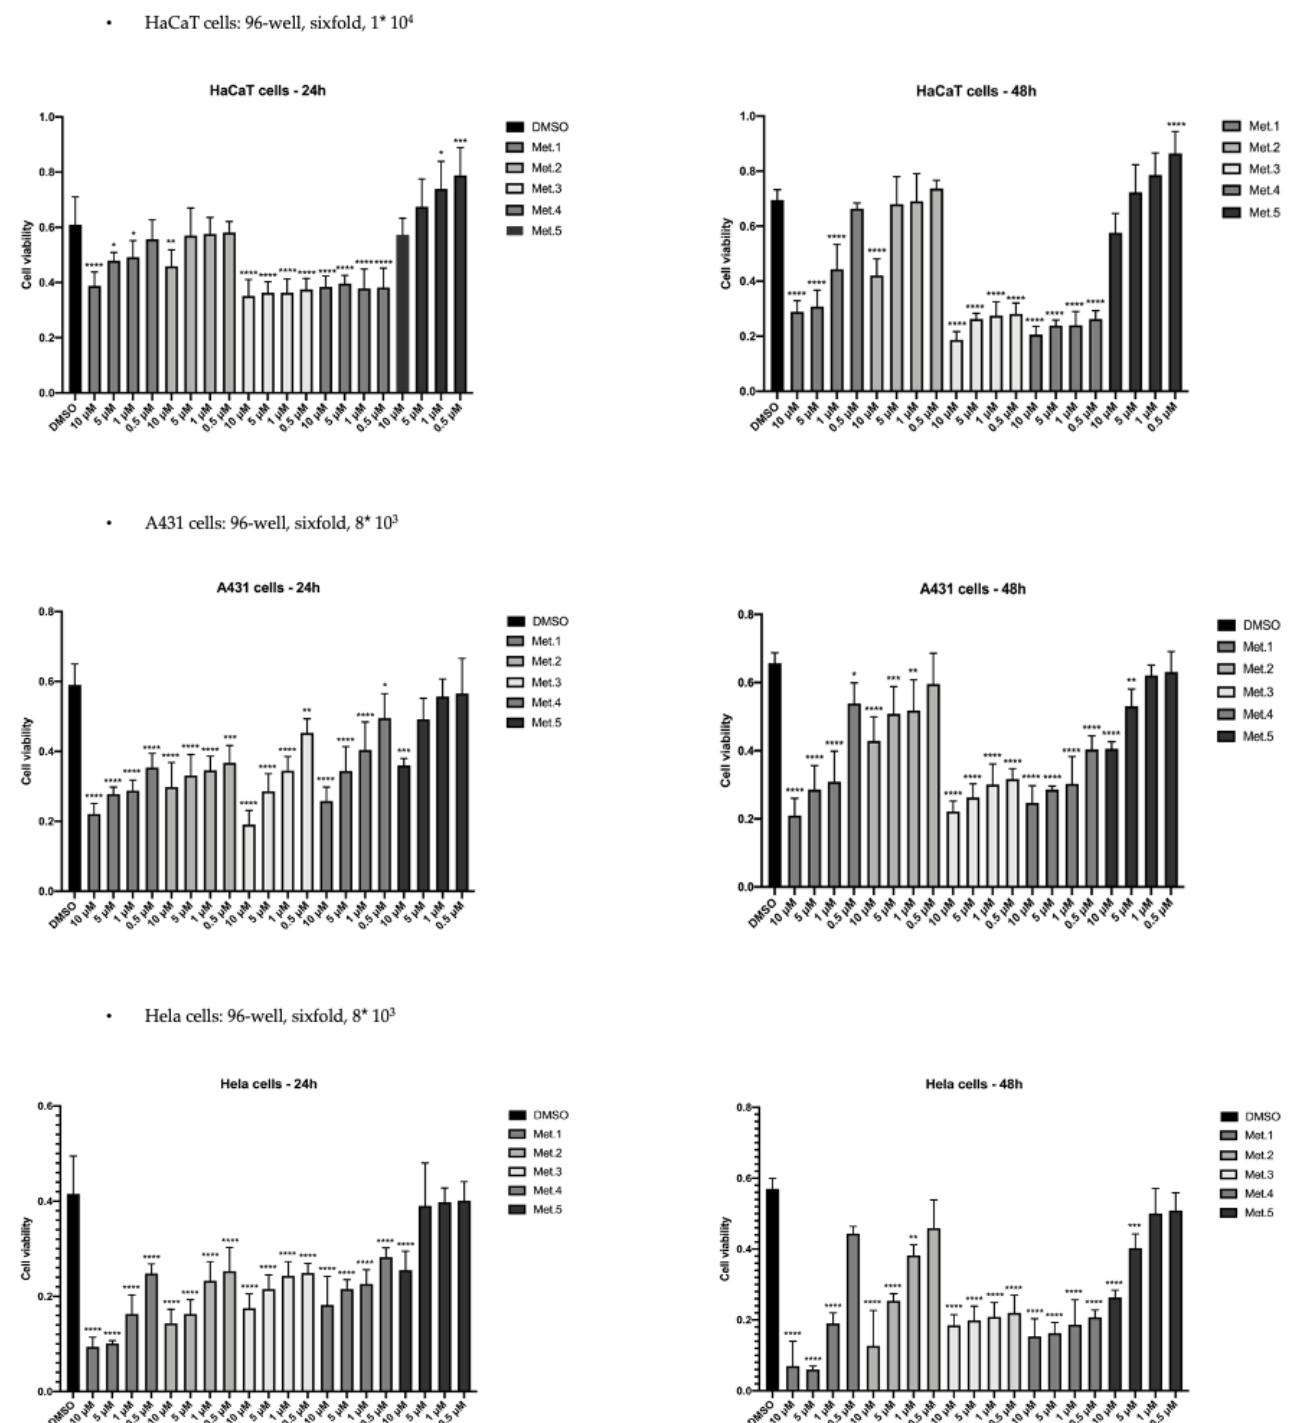
Figure 6. MTT viability assays with homoisoflavanoids 1 – 4 and N - p -coumaroyltyramine ( 5 ) from C. biflorum on HaCaT, A431 and Hela human cell lines. Statistical analyses were performed using one-way ANOVA and Dunnett’s multiple comparisons test. Levels of significance between points of expression are indicated (**** p < 0.001, *** p < 0.01, ** p < 0.02, * p < 0.05).